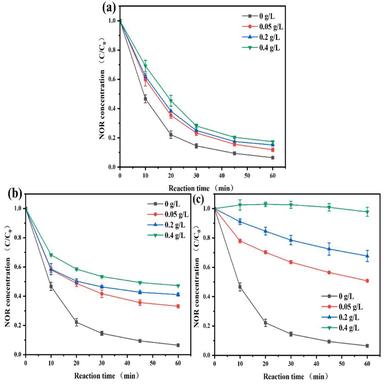
The effect of Cl- (a), CO3 2− (b) and PO4 3− (c) on NOR degradation. (General condition: = 10 mg/L, PMS = 0.4 g/L, catalyst = 0.3 g/L, without adjusting the initial pH, T = 25±0.1◦C. The error bars represent results of three duplicates.).